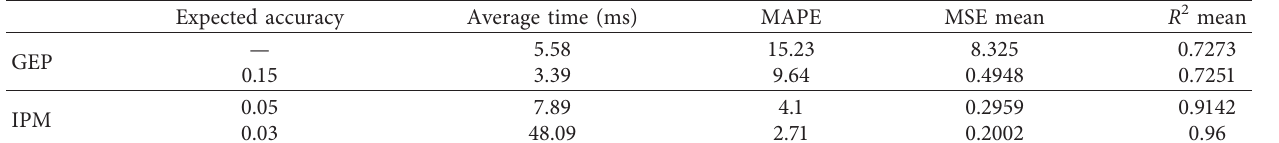
Table 3: Comparison experiment data of leek price